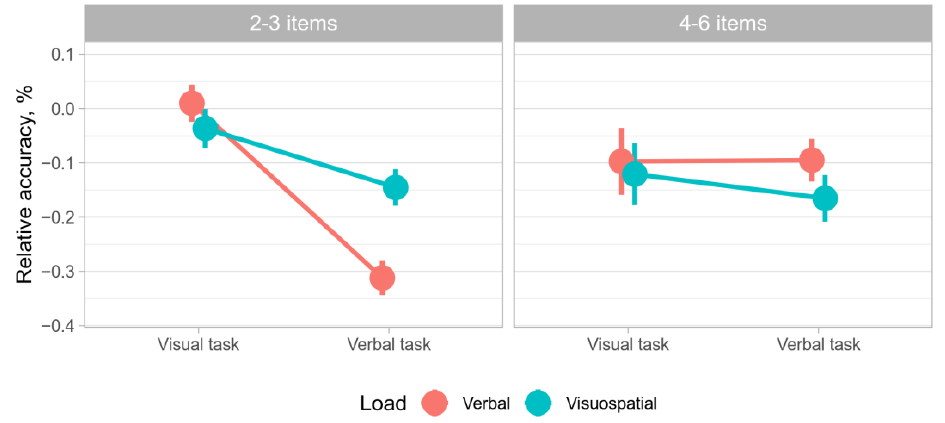
Figure 4. The two-way ANOVA results of the experimental sessions grouped by the number of items per trial.